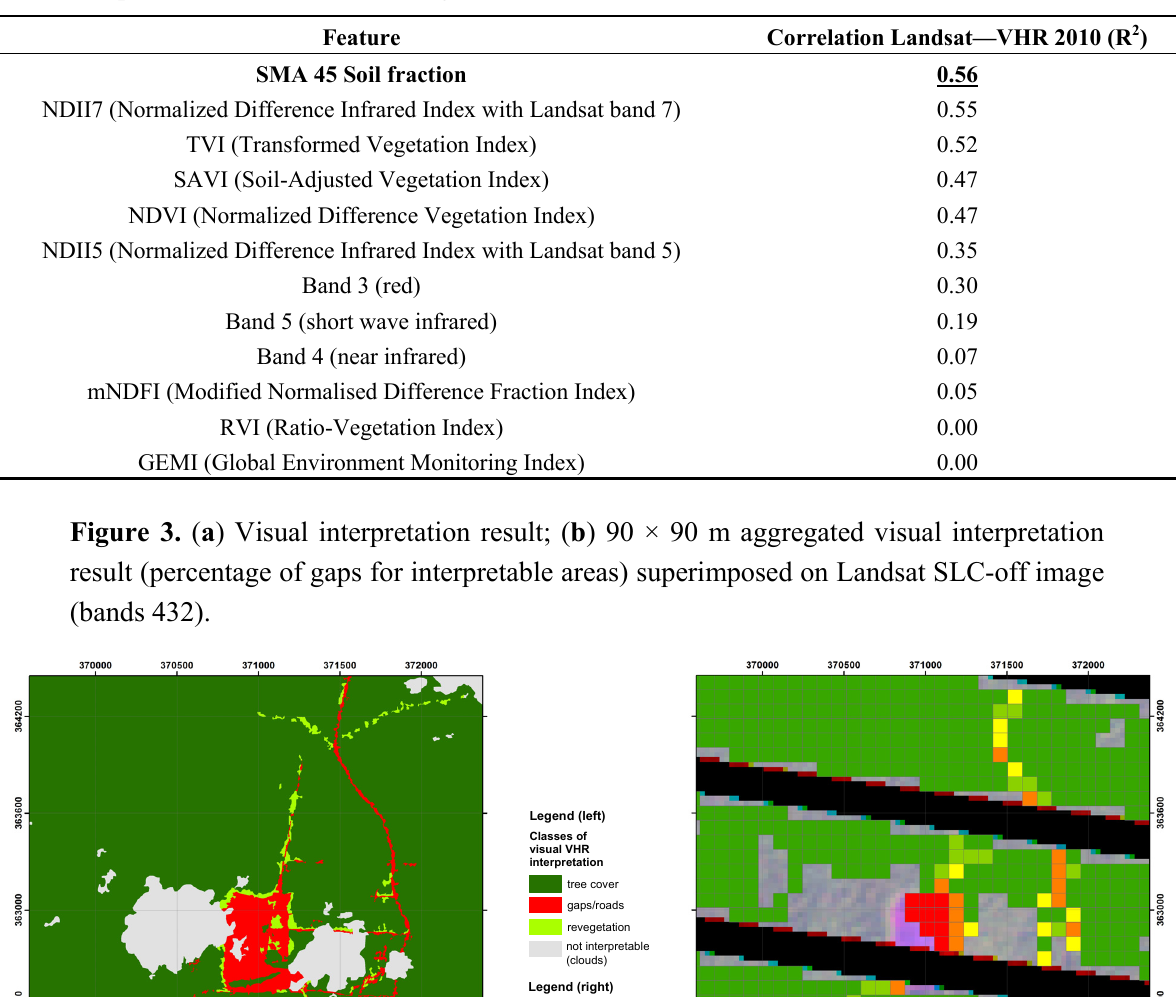
Table 2. R 2 values (all 90 m squares, n = 1,589) for percentage of gaps free of vegetation as obtained from the Very High Resolution (VHR) image (17 December 2010) in comparison to different features generated from Landsat (2 December 2010).